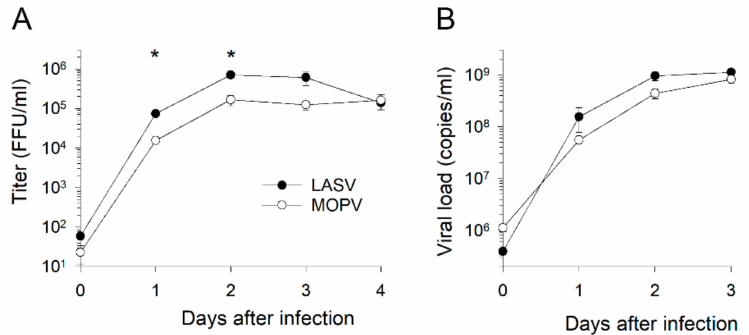
Figure 1. LASV and MOPV replication in HUVECs. ( A ) Viral titers, expressed in FFU/mL, and ( B ) vi- ral RNA loads, expressed in copies/mL, are presented according to the number of days after infection with LASV (black circles) or MOPV (white circles). Results are expressed as the mean ± standard error of the mean (SEM) from three different cell donors. Asterisks represent significant differences ( p < 0.05) between LASV and MOPV titers by a t